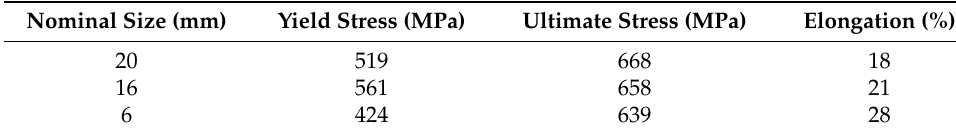
Table 2. Mechanical properties of steel reinforcement.